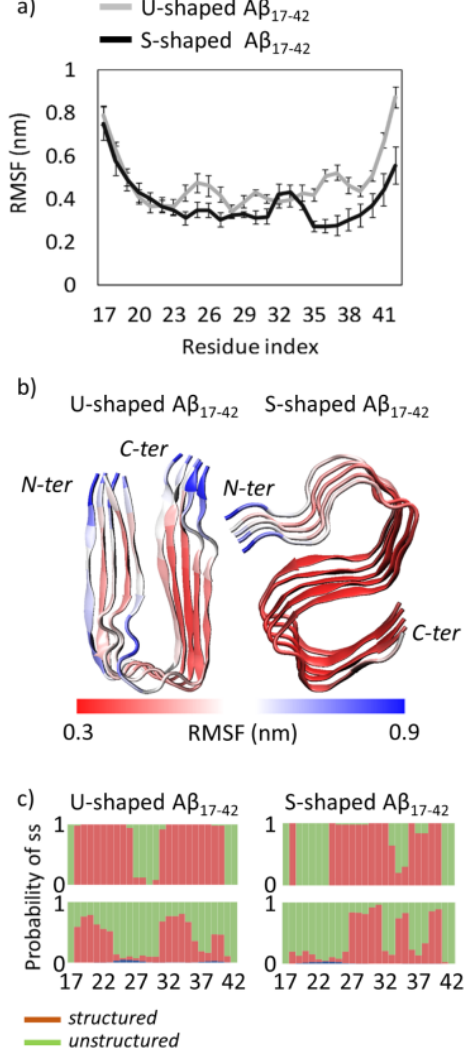
Figure 1. ( a ) U-shaped and S-shaped Root Mean Square Fluctuation (RMSF) of atomic positions averaged on each protein residue. Each average value and relative standard deviation was obtained by mediating the RMSF on the five considered protein chains (A–E); ( b ) U-shaped and S-shaped structural models coloured on the basis of RMSF values. The scale bar moves from red (RMSF = 0.3 nm) to blue (RMSF = 0.9 nm); ( c ) U-shaped and S-shaped residue secondary structure probability, calculated over 5 considered chains (A–E) in the PDB models (upper row) and on the Replica Exchange Molecular Dynamics (REMD) ensemble at 300 K (lower row). For the sake of clarity, the secondary structures are classified in structured (red) and unstructured (green). Moreover, the structured class does not contain helices (shown in blue) being their contribution negligible throughout the overall REMD ensemble at 300 K.